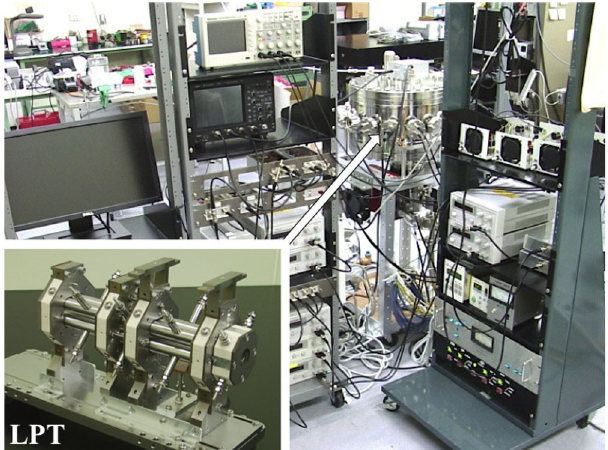
FIG. 1. An overall view of the S-POD system employed for the present resonance-crossing experiment. A compact LPT (lower left corner) has been installed in the chamber inside which the vacuum pressure is kept lower than 10 − 7 Pa. The main S-POD components, including an electron gun for neutral gas ionization, data-taking system, and ac and dc power supplies, are controlled by a personal computer, so that all the necessary experimental procedures are executed